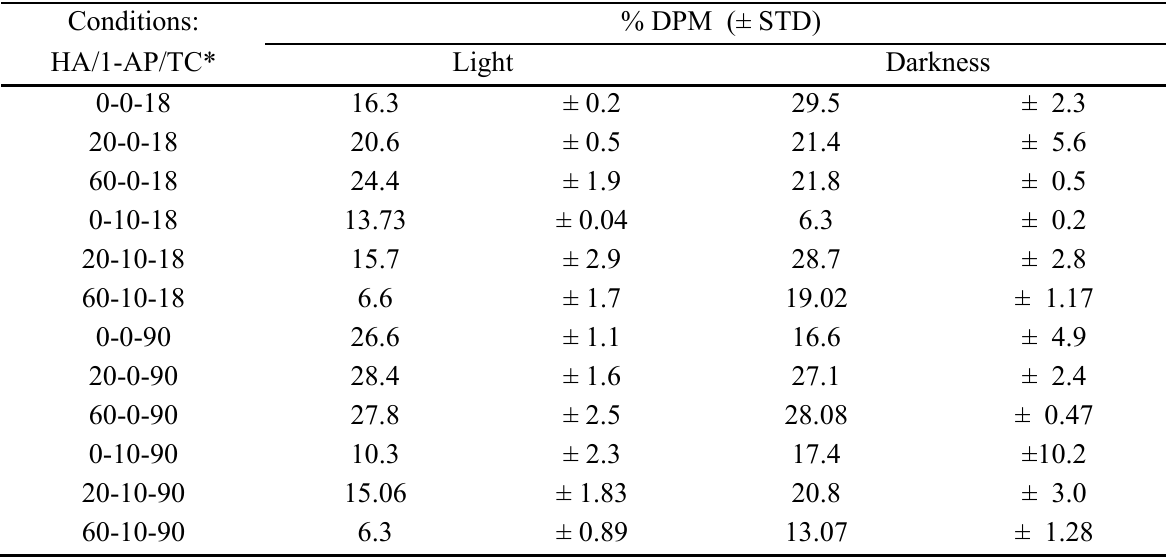
Table 2. Percent of 14 C-D-glucose mineralized ( ± STD) by heterotrophic bacteria after exposure to 1- AP in sunlight and darkness for 18 and 90 minutes, in the presence or in the absence of HA, for 18 and 90 minutes.